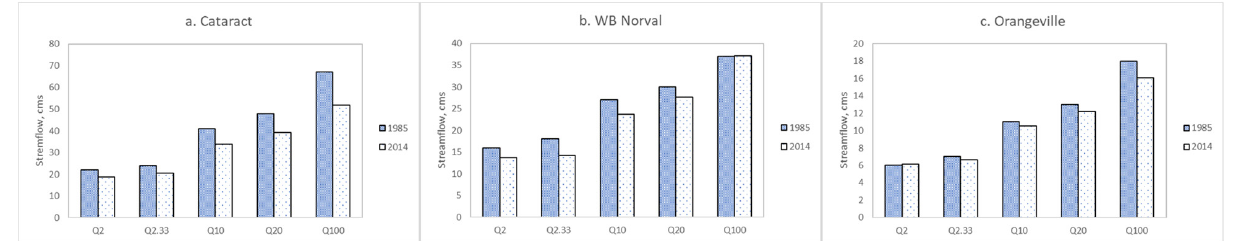
Figure 9. Comparison of the flood flows for the return periods Q 2 , Q 2.33 , Q 10 , Q 50 and Q 100 from 1985 to 2014 for two rural stream gauges ( c ) Orangeville and ( a ) Cataract and one urban gauge ( b ) WB Norval. The graph shows a decrease in the return level in 2014.